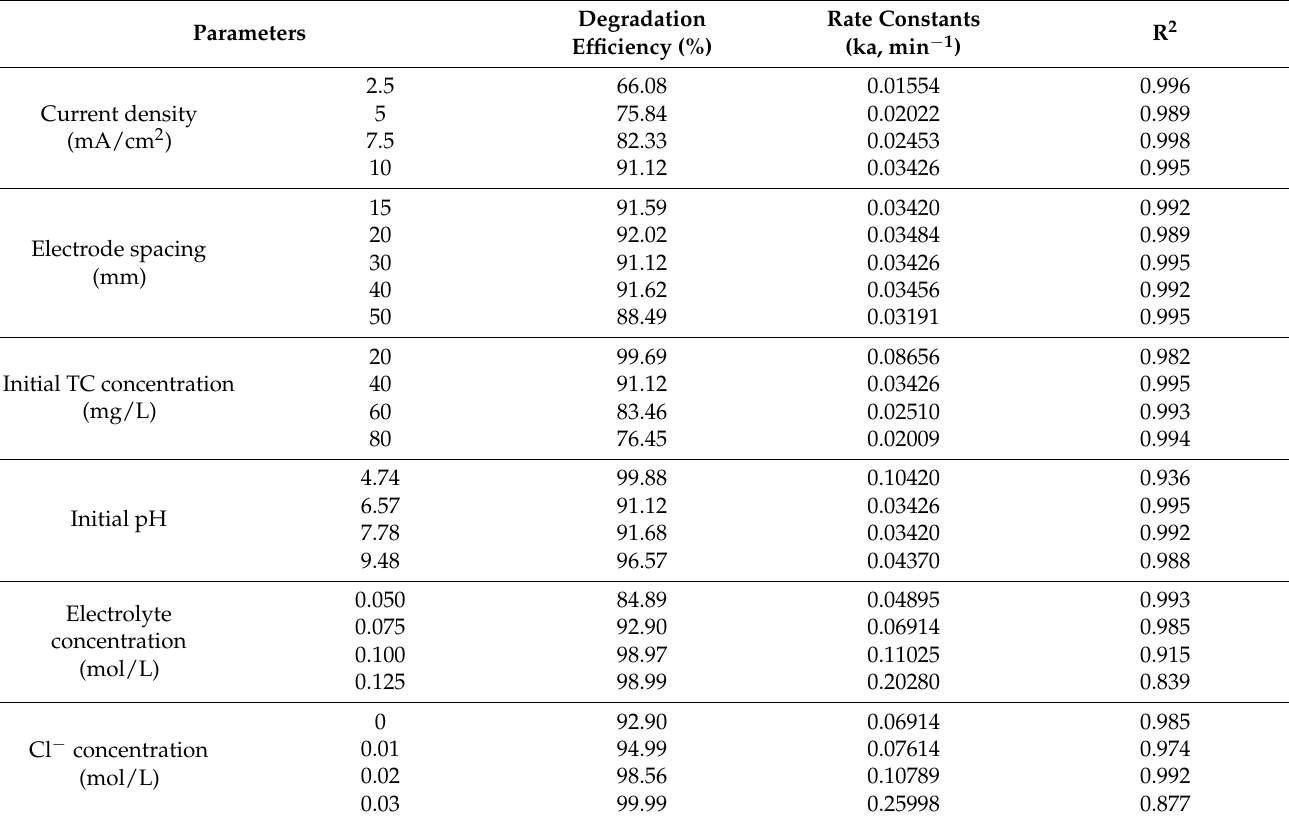
Table 1. Efficiency and kinetics of TC electrochemical